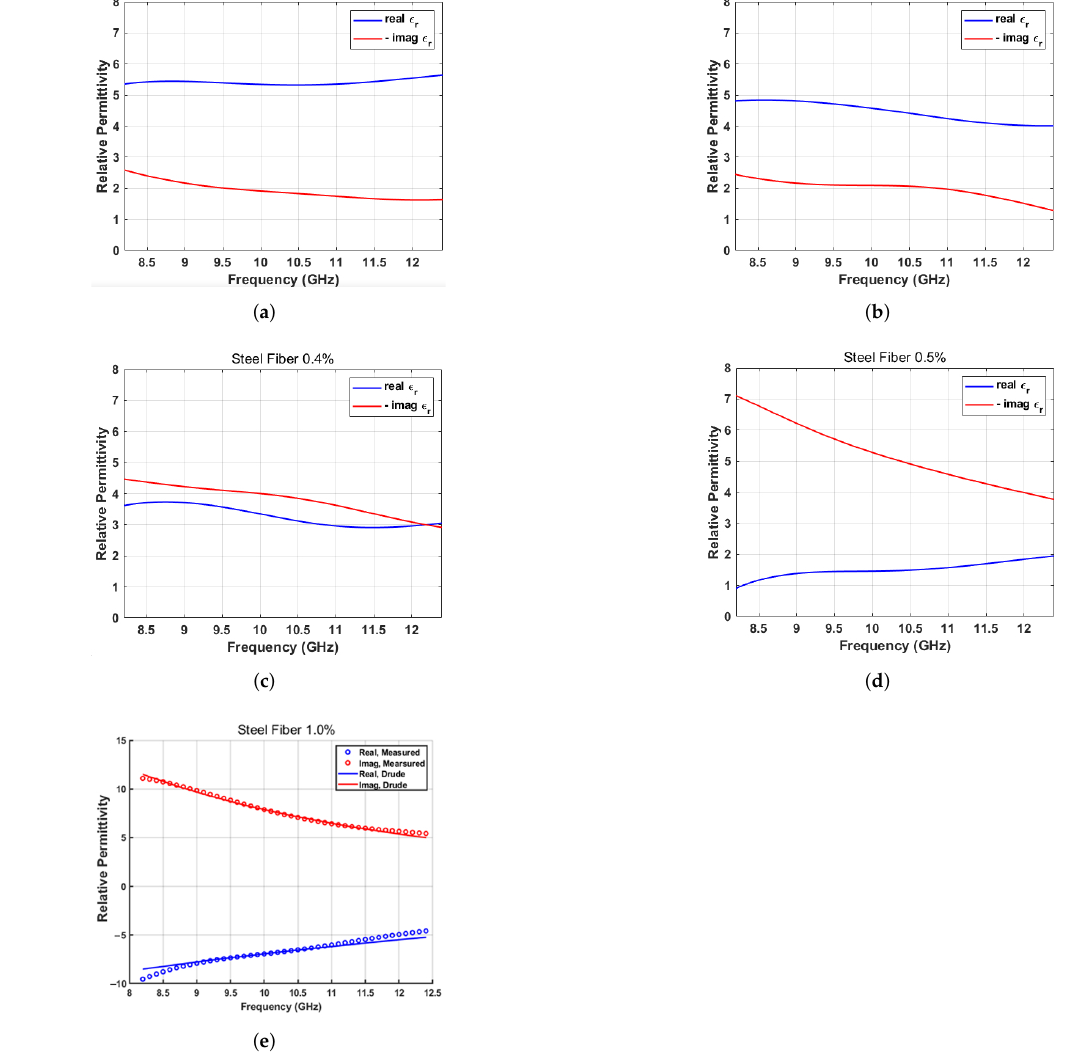
Figure 10. Complex permittivity of each fiber concentration. ( a ) SFRC 0.2%. ( b ) SFRC 0.3%. ( c ) SFRC 0.4%. ( d ) SFRC 0.5%. ( e ) SFRC